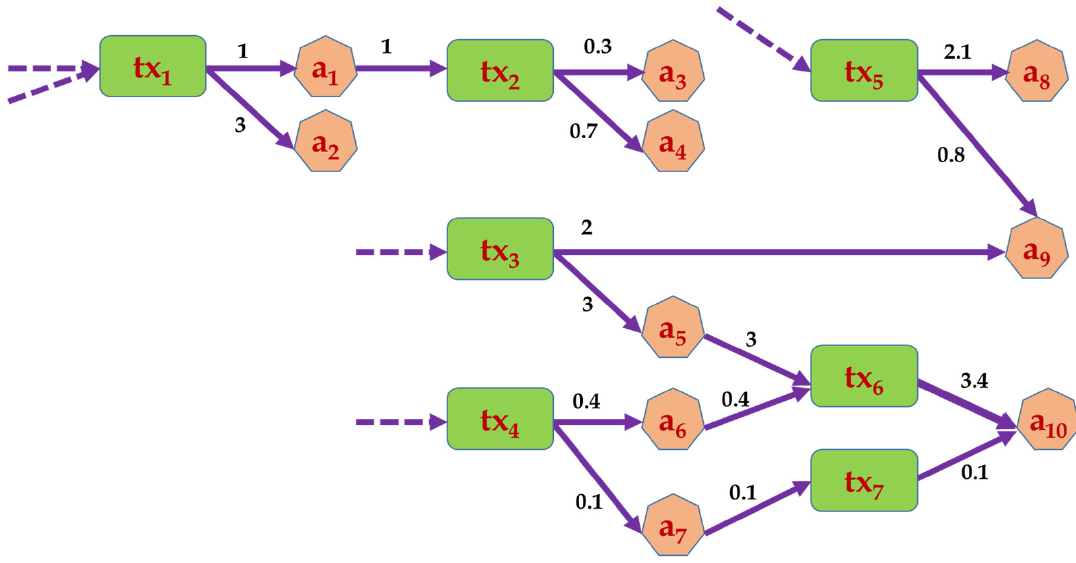
Figure 3. Sample Bitcoin Graph Features: network of 10 addresses and 7 transactions.